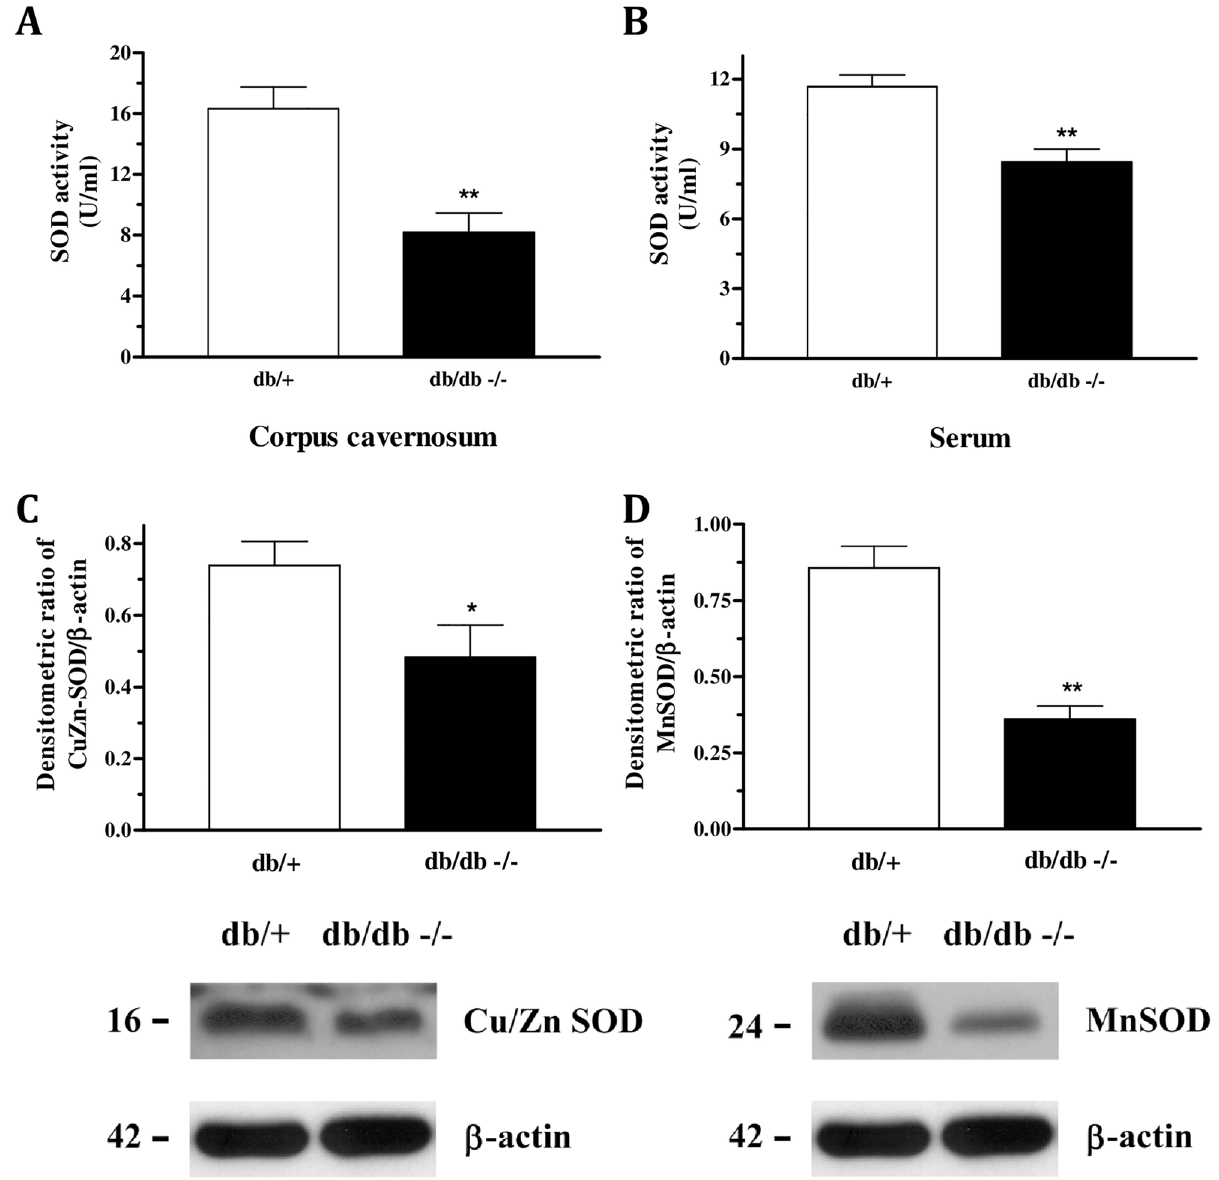
Fig 6. Decreased activity of the antioxidant enzyme SOD in the corpus cavernosum (Panel A) and serum (Panel B) of db/db mice compared to db/+ mice. Protein expression of CuZn (Panel C) and Mn SOD (Panel D) measured by western blot were diminished in the CC of db/db mice. Data represents the mean ± S.E.M. of 4 – 6 experiments. * P < 0.05 and ** P < 0.01, compared to db/+